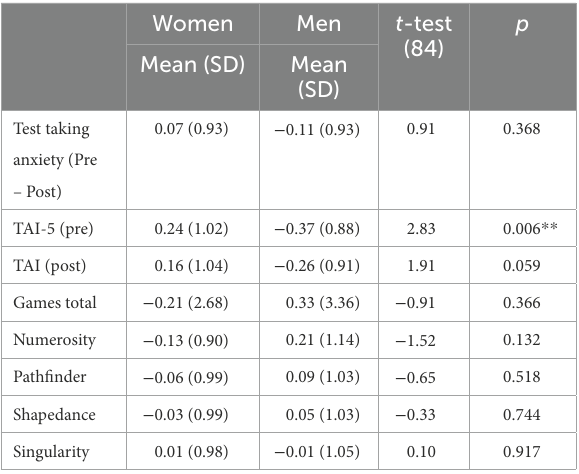
TABLE 5 Means, standard deviations (SD) and group differences between men and women on test taking anxiety and game